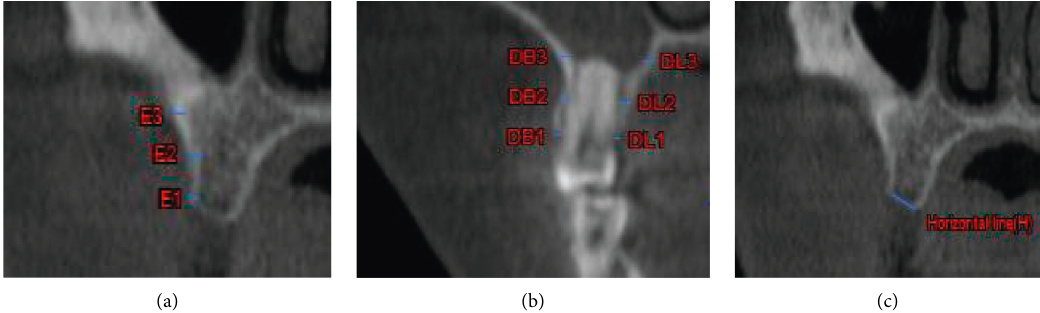
Figure 2: (a) Horizontal line (H) drawing at bone ridge level from the buccal to the palate wall. (b) Alveolar bone thickness at dentate sites in the coronal plane, measured perpendicular to three different levels of the long axis of the root on buccal and lingual walls, respectively: crestal bone level (DB1, DL1), mid root level (DB2, DL2), and apical bone level (DB3, DL3). (c) Cortical bone thickness measured for edentulous sites at the three levels: crestal bone thickness (E1), bone thickness 5mm from E1 (E2), and bone thickness 10mm from E1 (E3). # DB: dentate for buccal side and DL: dentate for lingual